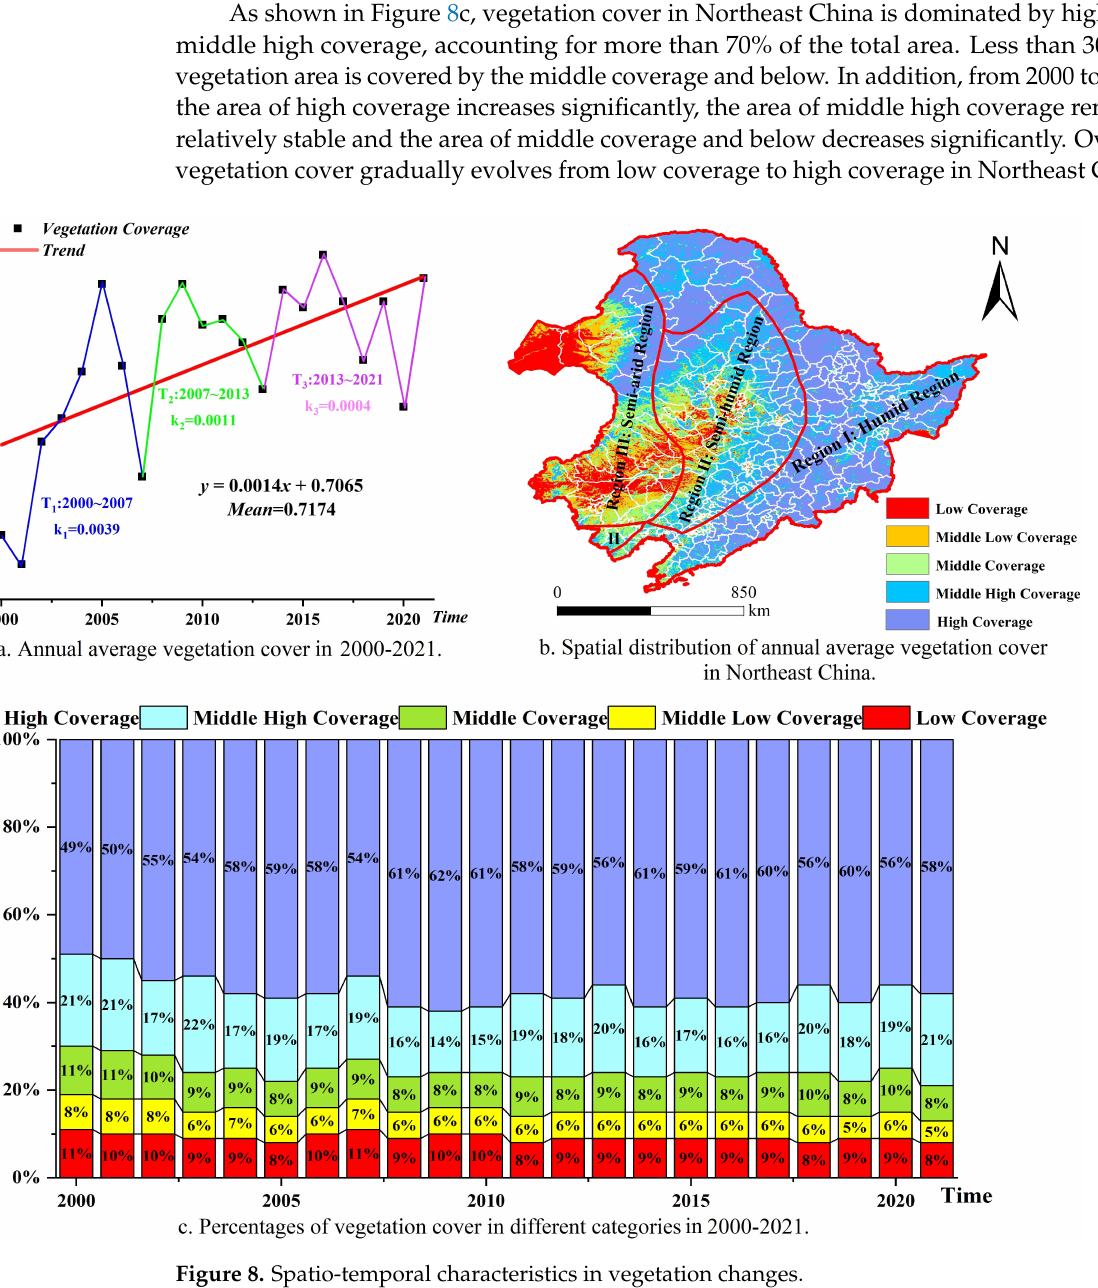
Figure 8. Spatio-temporal characteristics in vegetation